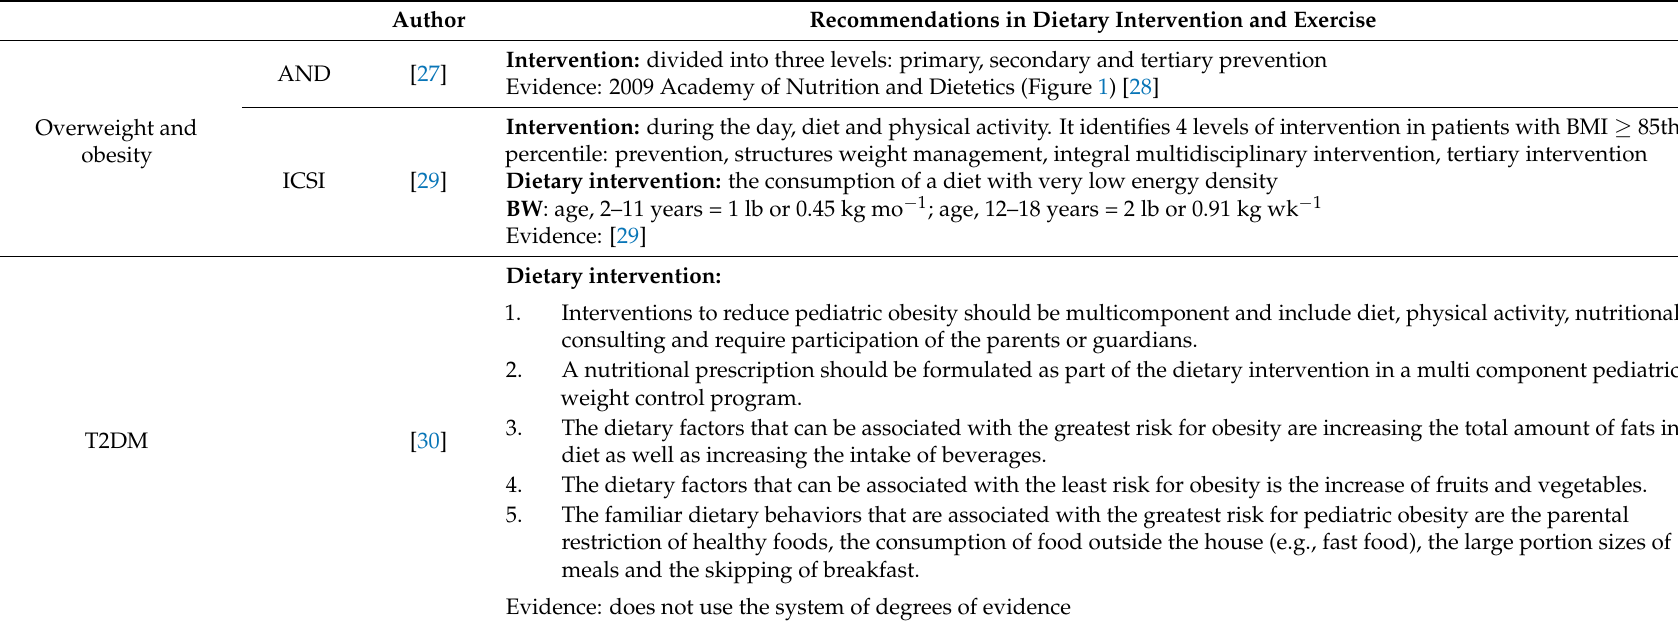
Table 3. Guidelines and consensus on the treatment of overweight and obesity: children and adolescents